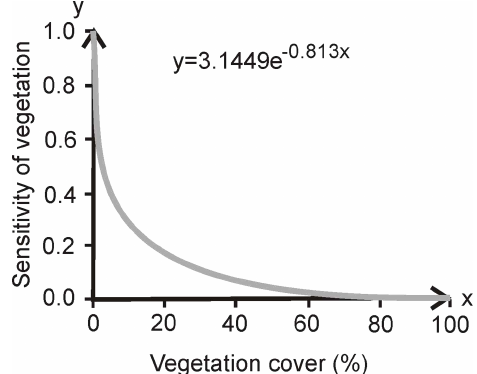
Figure 9. Relation between the vegetation cover and the sensitivity to wind erosion (NAM, 2002). The vegetation cover was calculated on the basis of a well-established direct relationship exists between the vegetation intensity and the NDVI (Huete et al.,